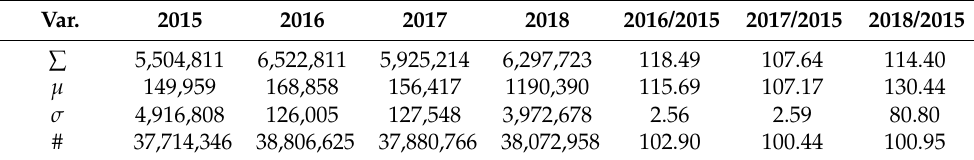
Table 2. Evolution of assets over